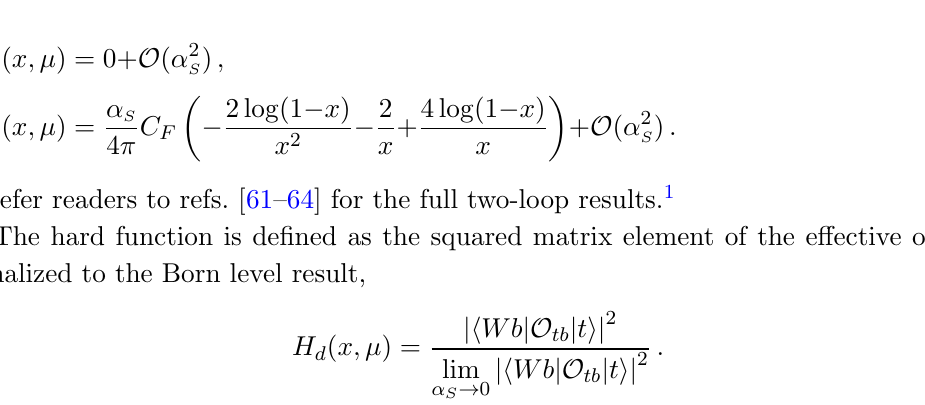
Figure 4 . One-loop QCD form factor for heavy-to-light